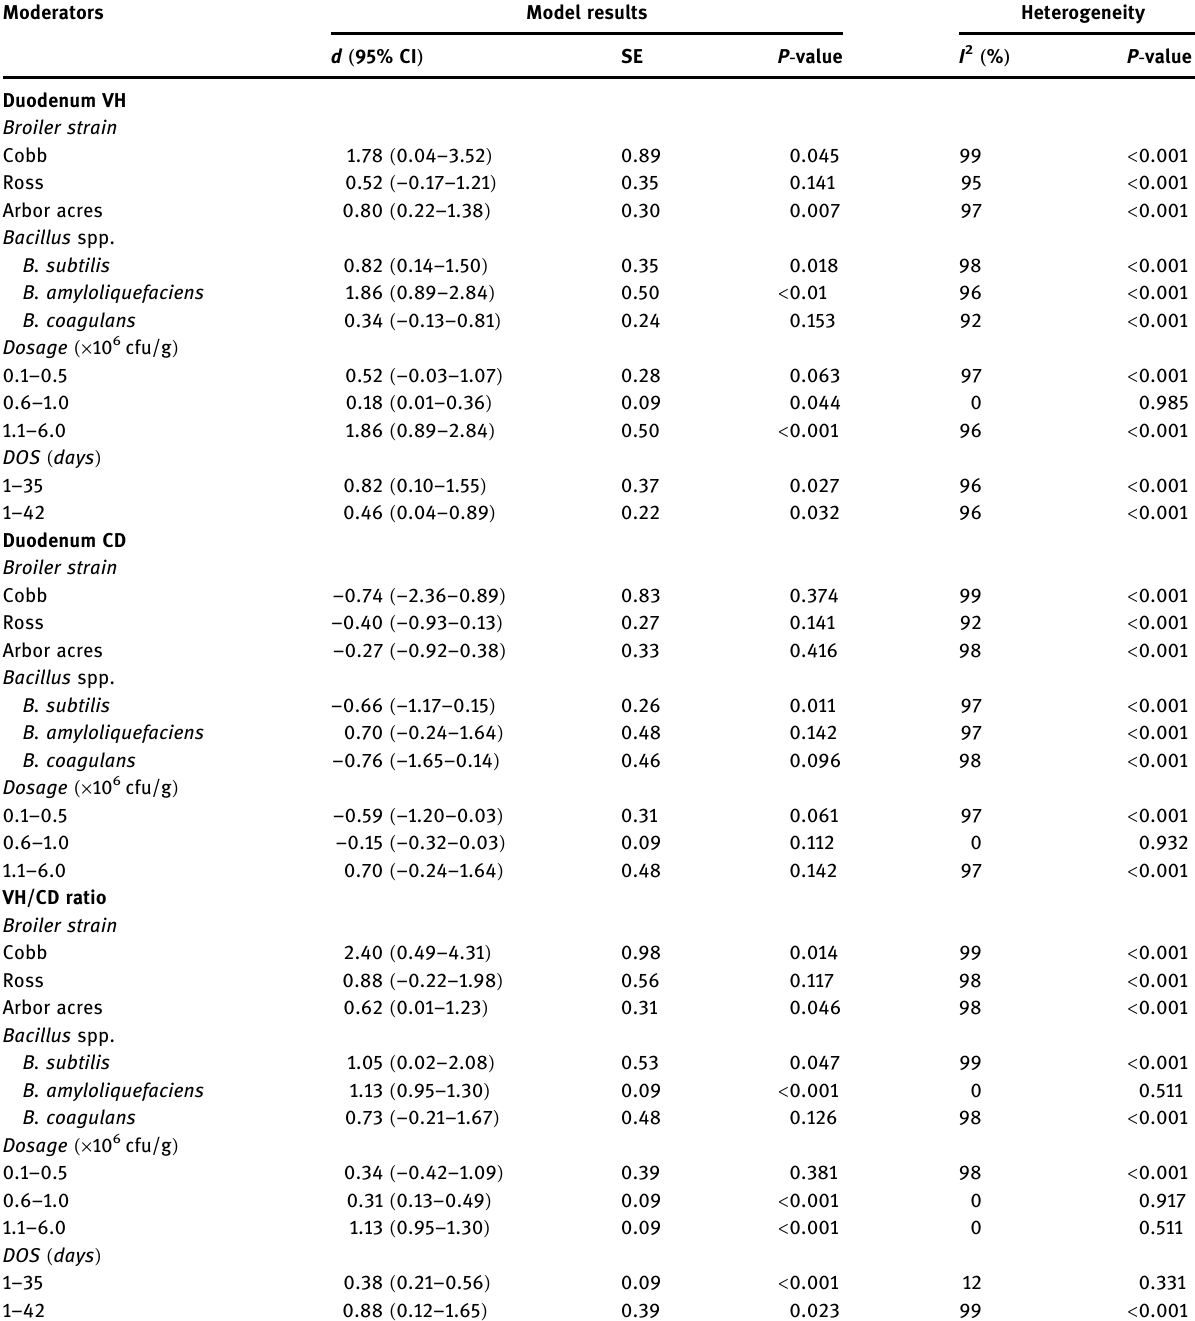
Table 4: Impact of moderators on duodenal histomorphometry of broilers fed Bacillus - supplemented diets Moderators